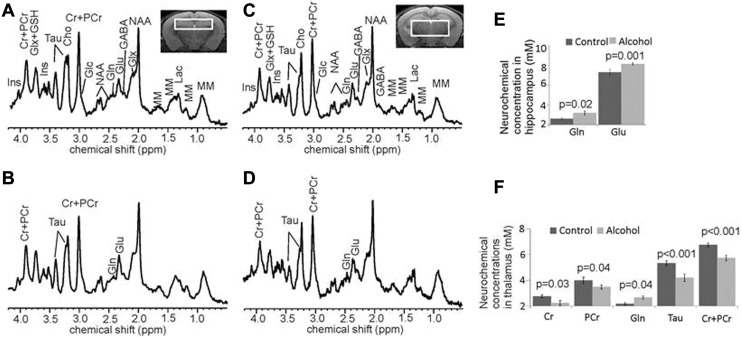
Representative in vivo 1H-MR spectra and corresponding voxel locations. (A) Hippocampus from an age-matched control mouse, (B) hippocampus from a 7-month-old Lieber-DeCarli alcohol liquid diet treated mouse, (C) thalamus from an age-matched control mouse, and (D) thalamus from a 7-month-old Lieber-DeCarli alcohol liquid diet–treated mouse. Comparisons of the neurochemical concentrations between control- (n = 7) and alcohol-treated (n = 7) mice in hippocampus (E) and thalamus (F). The NAA peak heights were used to normalize the MR spectra as there was no statistical difference in the NAA peak heights between the groups in the measured regions. Data presented as mean ± standard error of the mean. Ace indicates acetate; Alc, alcohol; Cho, choline-containing compounds; Cr, creatine; GABA, γ−aminobutyric acid; Glc, glucose; Gln, glutamine; Glu, glutamate; Glx, glutamate + glutamine; GSH, glutathione; Ins, myo-inositol; Lac, lactate; MM, macromolecules; NAA, N-acetylaspartate; NAAG, N-acetylaspartylglutamate; PCr, phosphocreatine; Tau, taurine; tCr (total creatine), Cr + PCr.